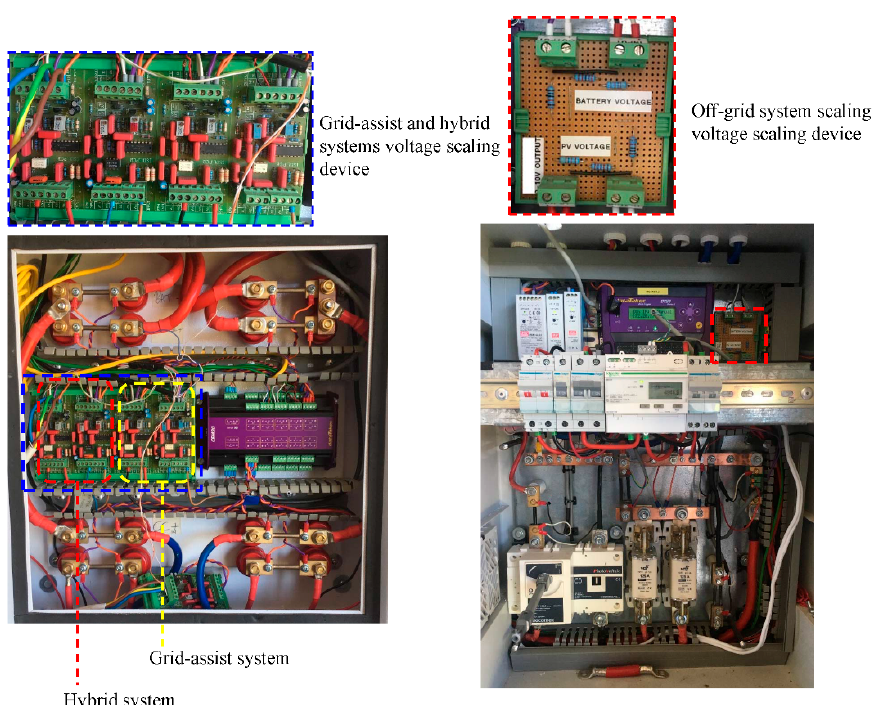
Figure 7. The PV systems electrical parameters data acquisition system indicating the three systems’ voltage scaling devices and other measuring instruments.